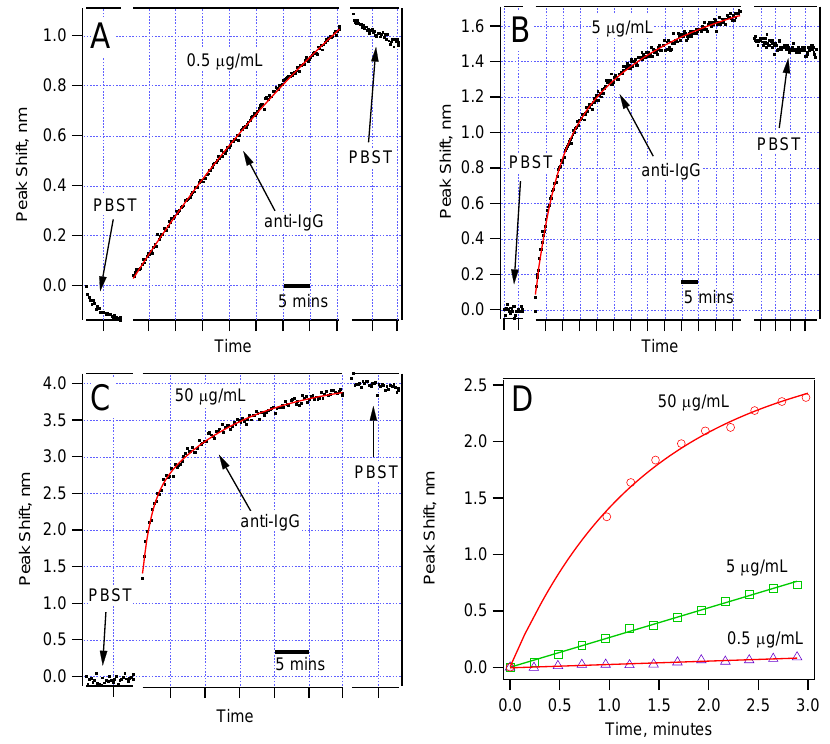
Figure 5. Sensor response for three different concentrations of anti-IgG: ( a ) 0.5 µg/mL; ( b ) 5.0 µg/mL; ( c ) 50 µg/mL; Note that different wavelength scales are used to show the details of the dependence. The time scale is expressed using scale bars. The data fit best to double exponential functions; ( d ) Comparison of the peak shift in the first few minutes of the anti-IgG binding showing different rates for different